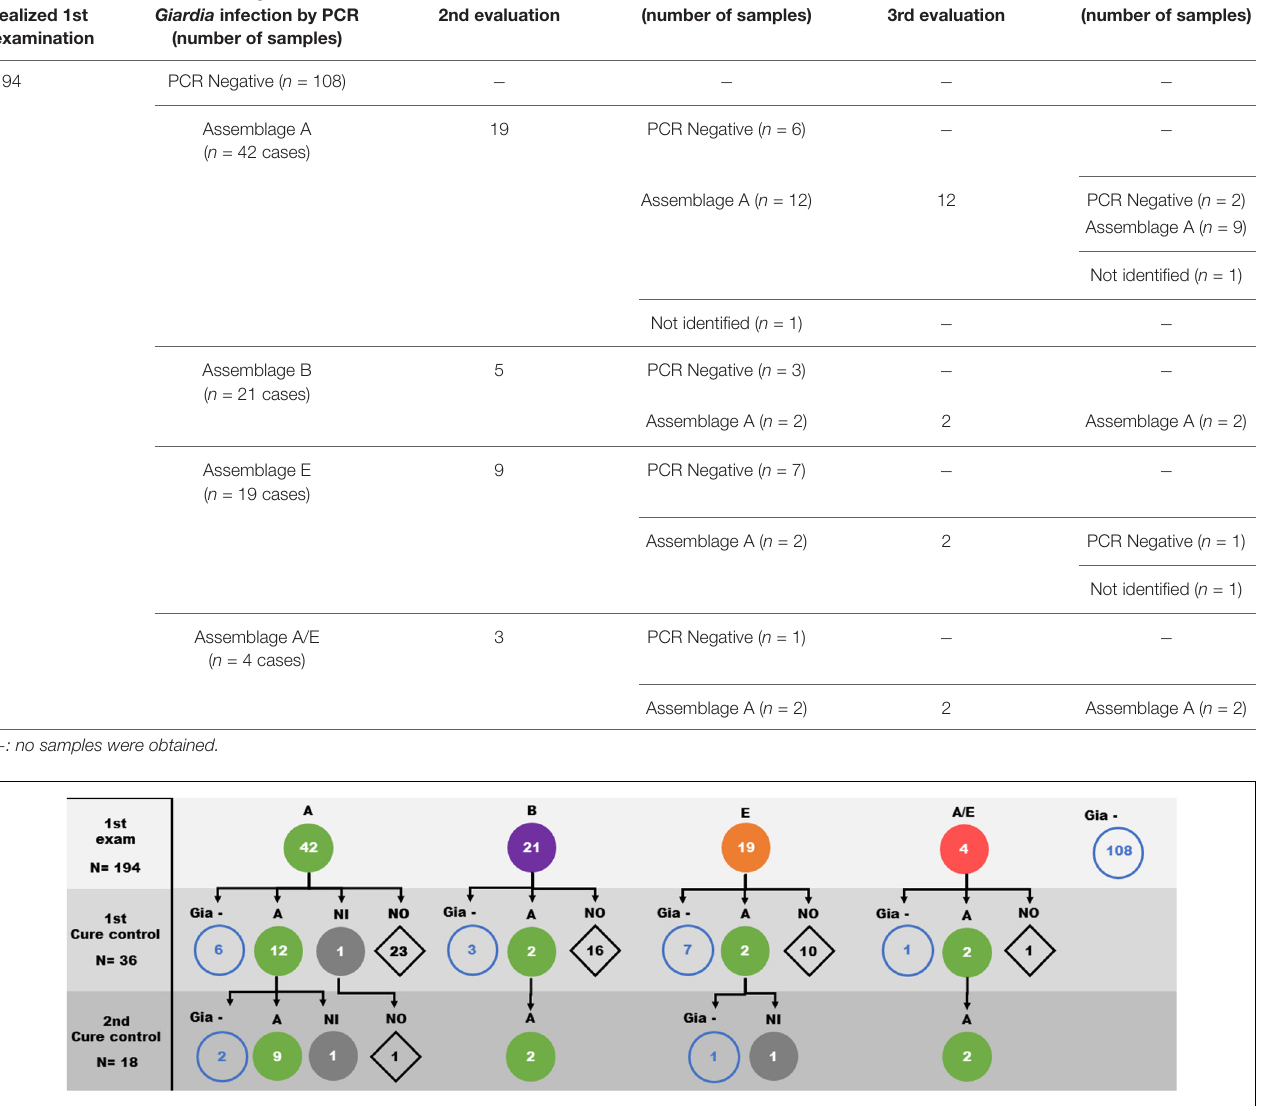
cats and dogs can freely roam and livestock might be